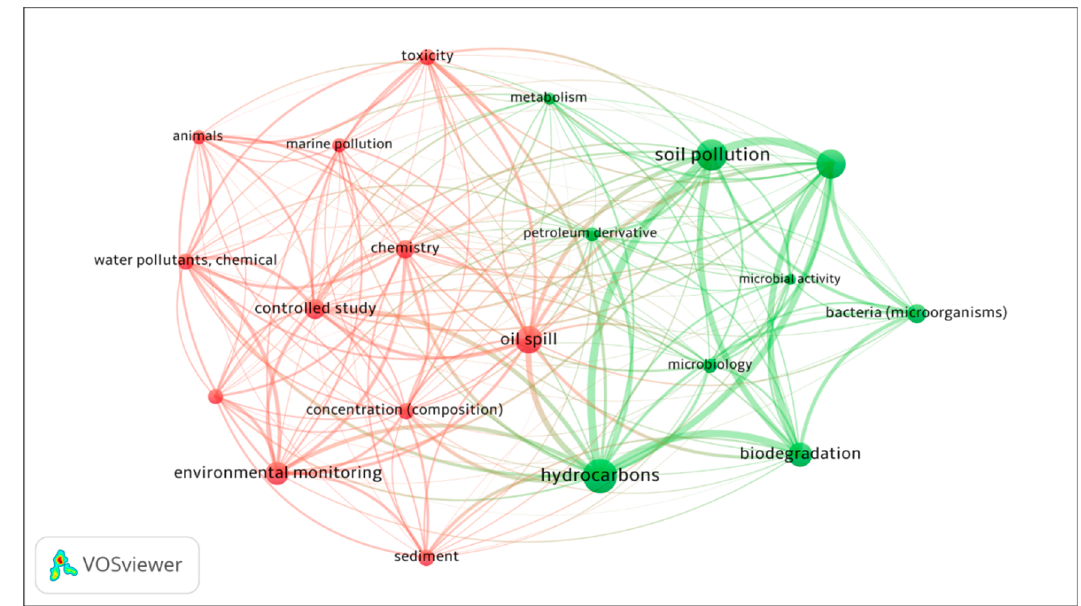
Figure 2. Co-occurrence network in the research field. Co-words are mapped into two major clusters implying the research themes (red: environmental monitoring; green: remediation mechanism).